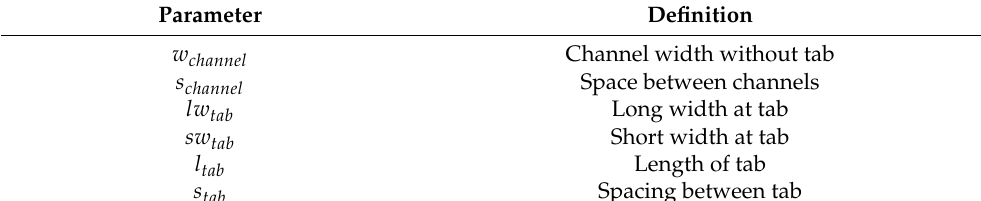
Table 1. Structural parameters and definition of the high-speed signaling channel with tabbed routing.